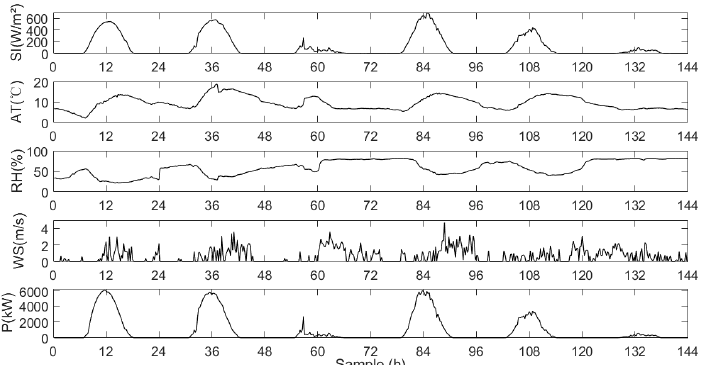
Figure 6. Solar irradiation (SI), air temperature (AT), relative humidity (RH), wind speed (WS), and PV power (P).